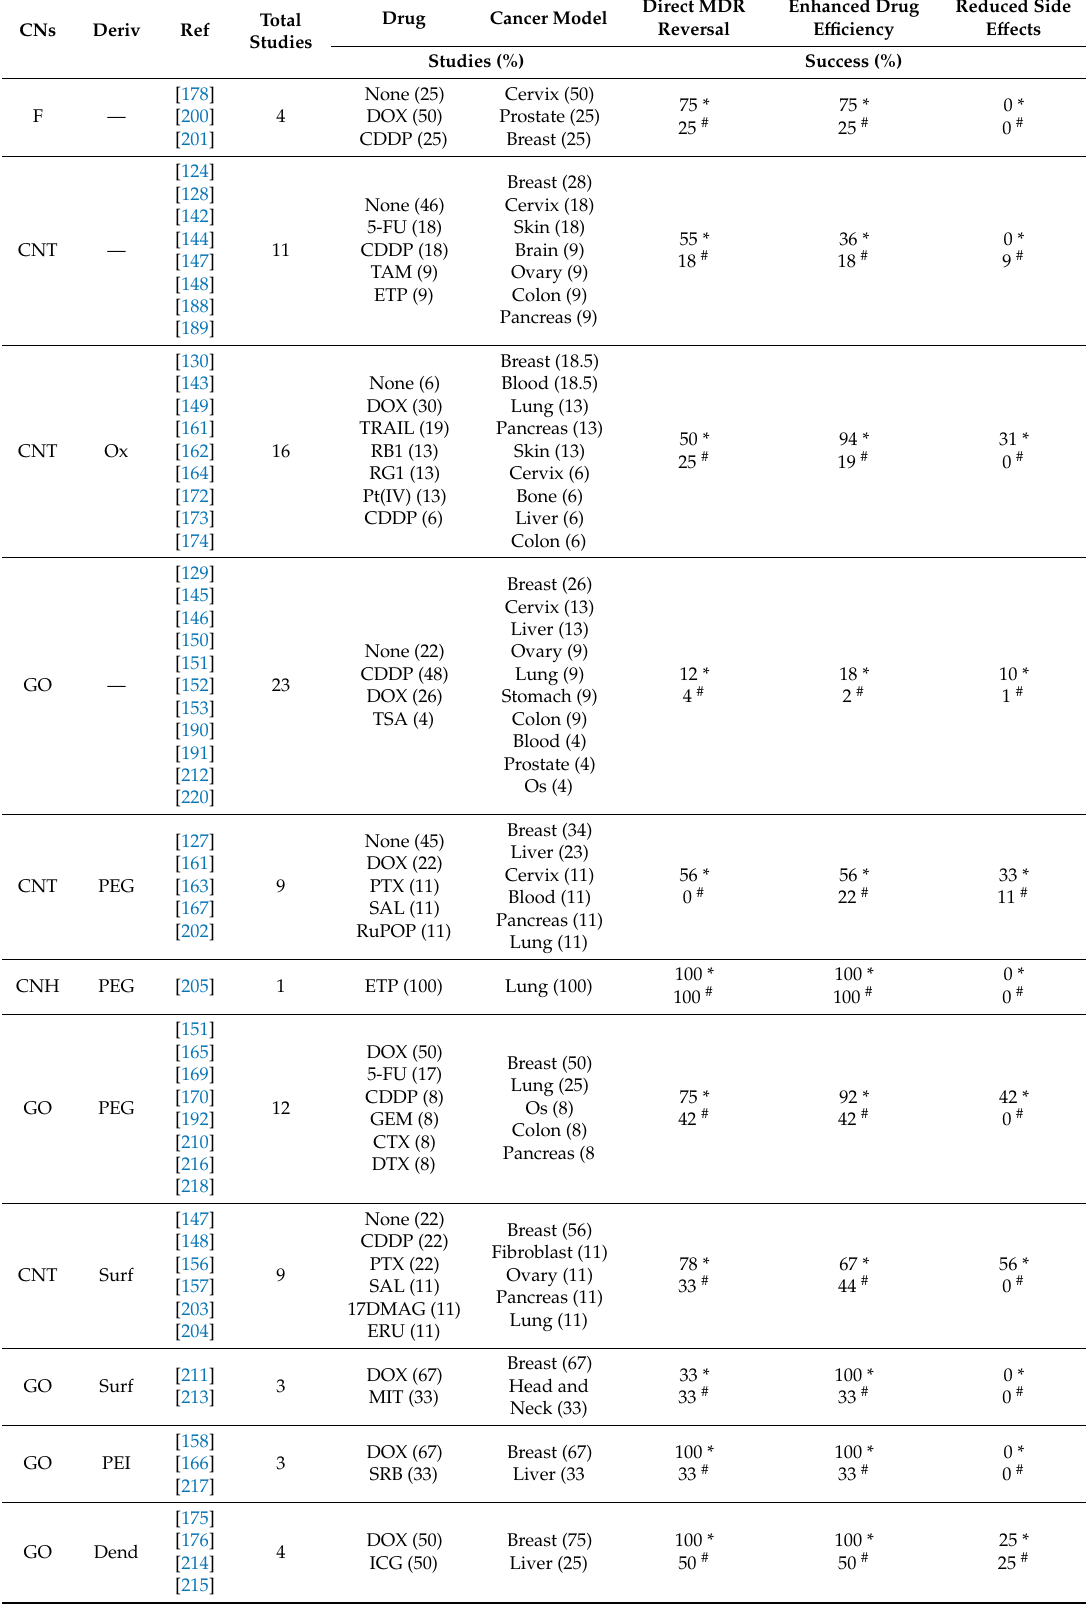
Table 8. Outcomes, strength and weakness of CN based system proposed for MDR reversal reviewed in this paper. Percentages are calculated based on the total studies, with some papers covering more studies